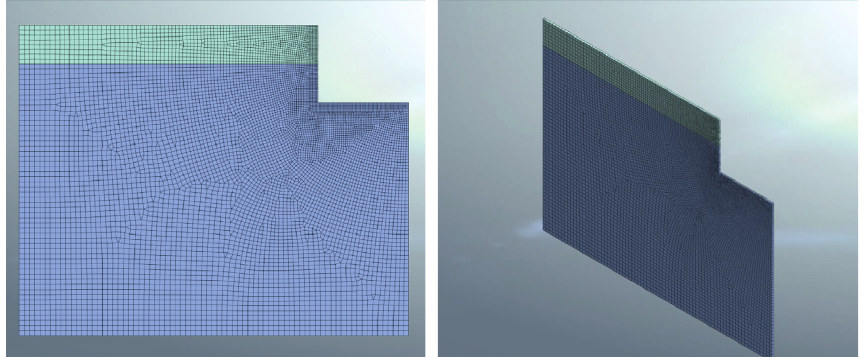
Figure 2: Numerical calculation model.